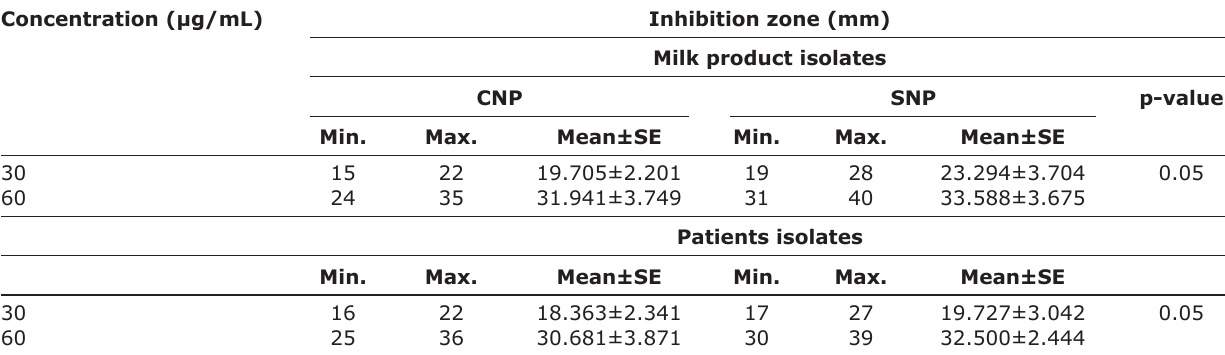
Table-4: Inhibitory effect of CNP and SNP on E. coli O157:H7 isolates from milk products and diarrheal patients. Concentration